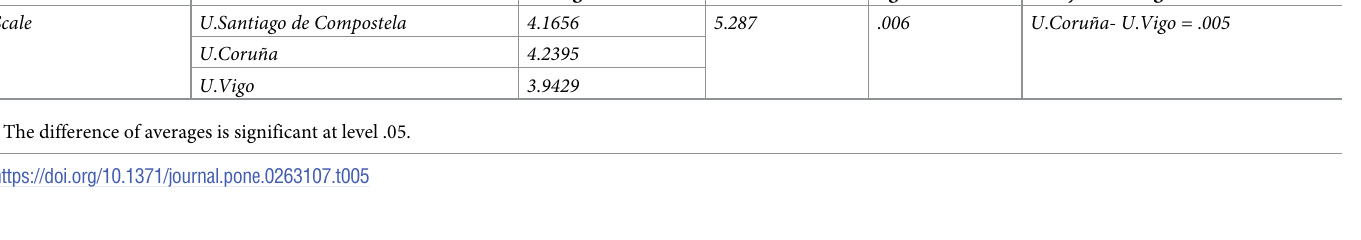
Table 6. ANOVA results for contrast of independent averages.